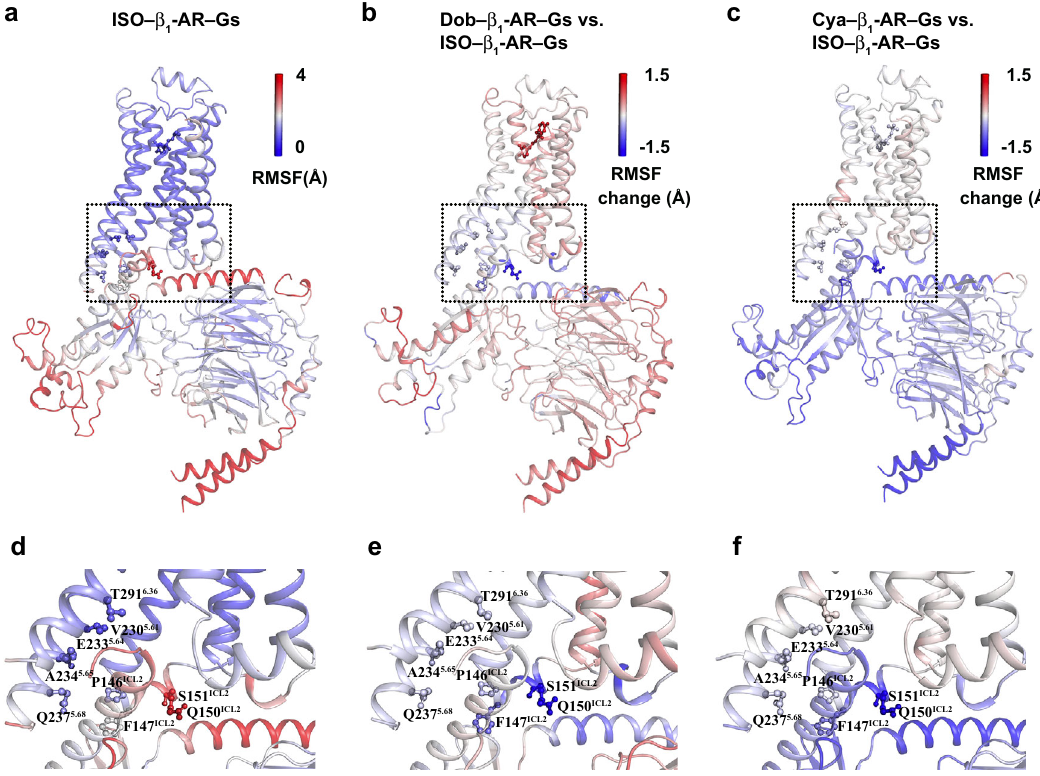
Fig. 4 Flexibility changes of the agonist – β 1 -AR – Gs complexes observed in GaMD simulations. a , d The root-mean-square fl uctuations (RMSFs) of the isoproterenol – β 1 -AR – Gs complex. b , e Changes in RMSFs of β 1 -AR and Gs when the dobutamine – β 1 -AR – Gs complex compared with the isoproterenol – β 1 - AR – Gs complex. c , f Changes in RMSFs of β 1 -AR and Gs when the cyanopindolol – β 1 -AR – Gs complex compared with the isoproterenol – β 1 -AR – Gs